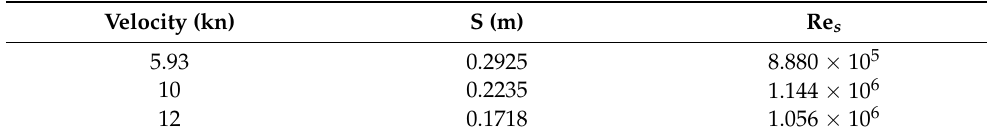
Table 3. The parameters of the transition point at different velocities.